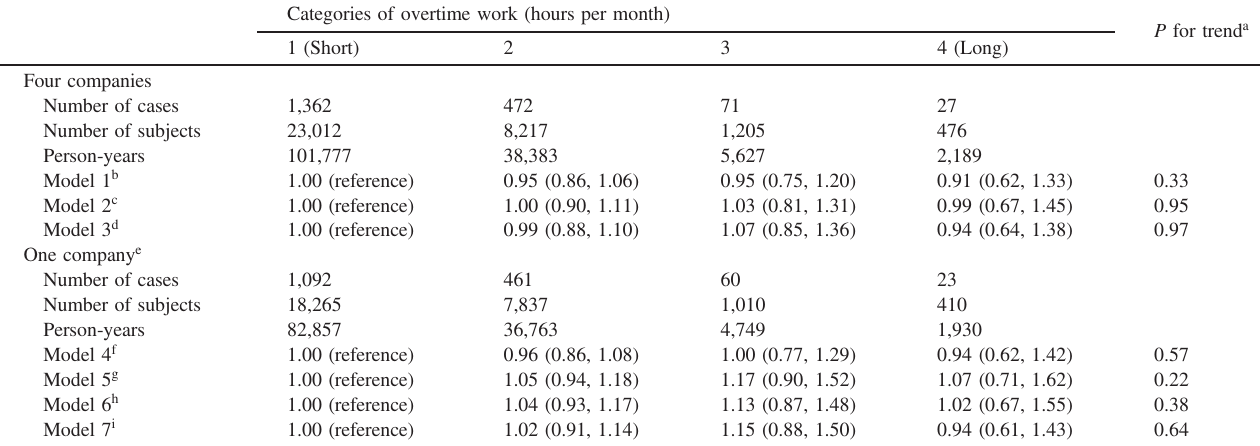
Table 2. Association of overtime working hours with risk of type 2 diabetes among Japanese workers Categories of overtime work (hours per